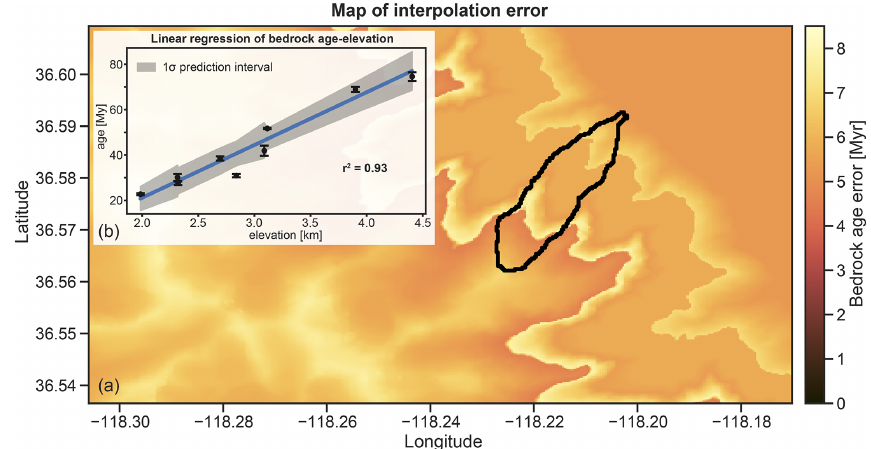
Figure 5. The raster image (a) displays the bedrock age interpolation error mapped to the topographic surface of the study area. The inset (b) shows the inverse variance-weighed linear regression employed as an age–elevation function, as well as the associated prediction interval with 1 σ confidence level.